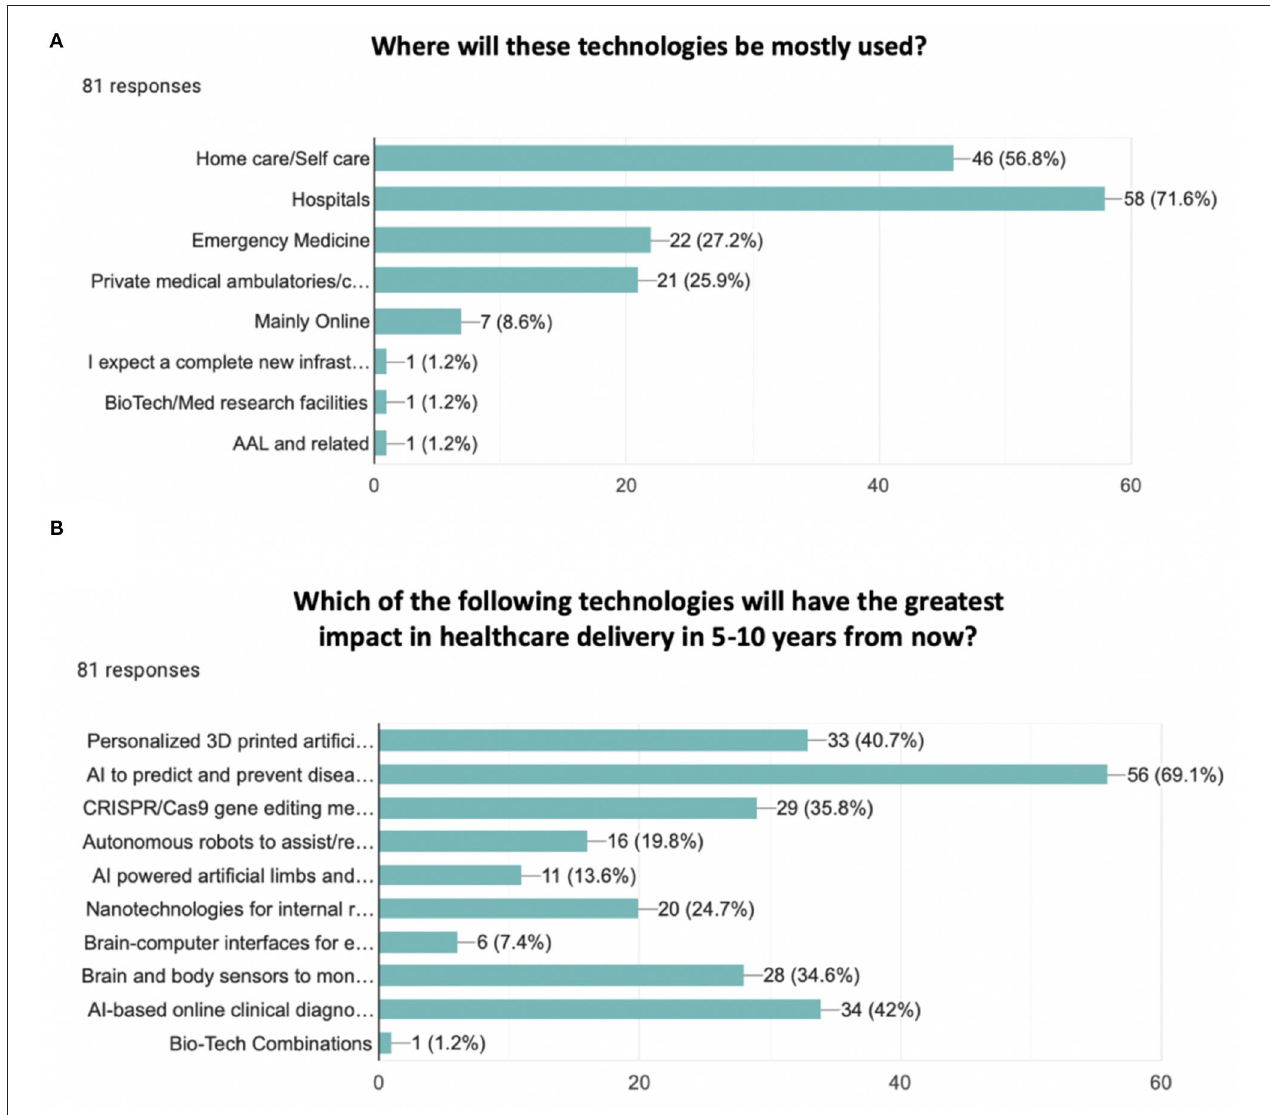
FIGURE 2 | Bar chart. (A) Where will these technologies be mostly used? Options were: Home care/self-care, hospitals, emergency medicine, private medical ambulatories/centers, mainly online, others. The most two relevant responses were hospitals (71.6%) and home care/self-care (56.8%). (B) Which of the following technologies will have the greatest impact in healthcare delivery in 5–10 years from now? Options were: personalized 3D printed artificial organs/limb prosthetics/skin, AI to predict and prevent disease development, CRISPR/Cas9 gene editing method to treat incurable diseases (e.g., HIV, cancer, malaria, Huntington’s disease, dementia), autonomous robots to assist/replace surgeons, AI-powered artificial limbs and exoskeletons, Nanotechnologies for internal repair and medication, Brain-computer interfaces for enhanced rehabilitation, brain and body sensors to monitor in real-time physiological and cognitive functioning, AI-based online clinical diagnostics, Other. The most three common answers were AI to predict and prevent disease development (69.1%), personalized 3D printed artificial organs/limb prosthetics/skin (40.7%), and AI-based online clinical diagnostics (42%).